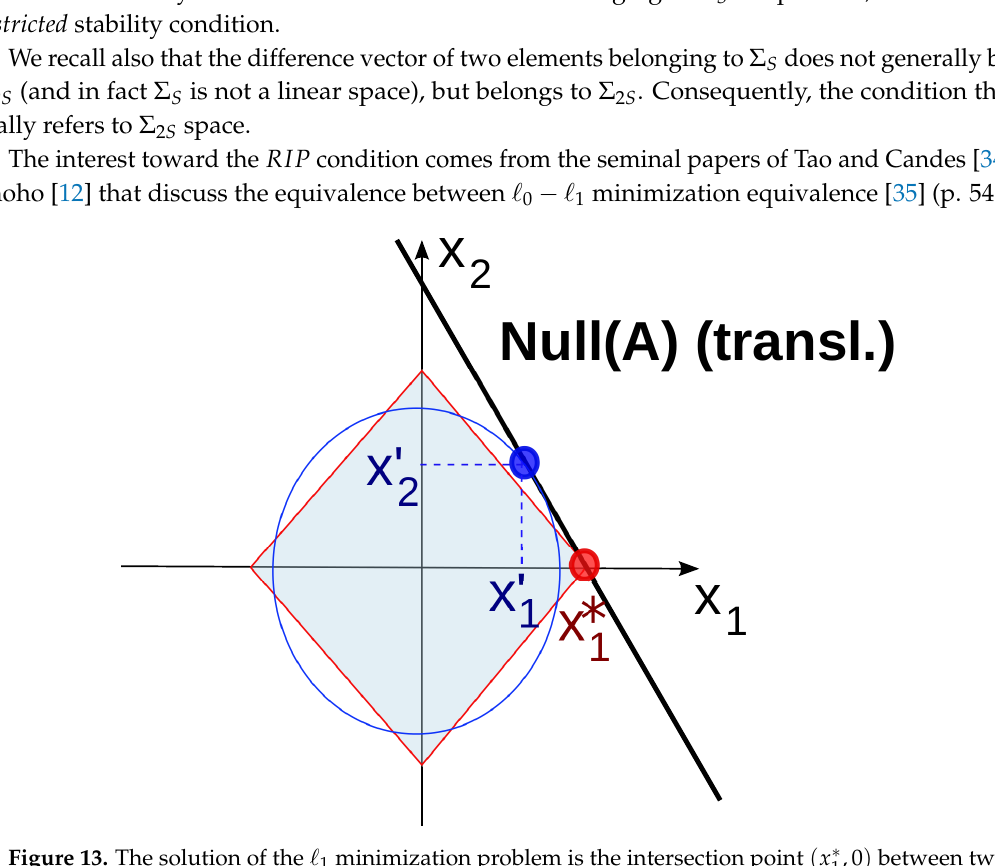
,0 ) between two 1